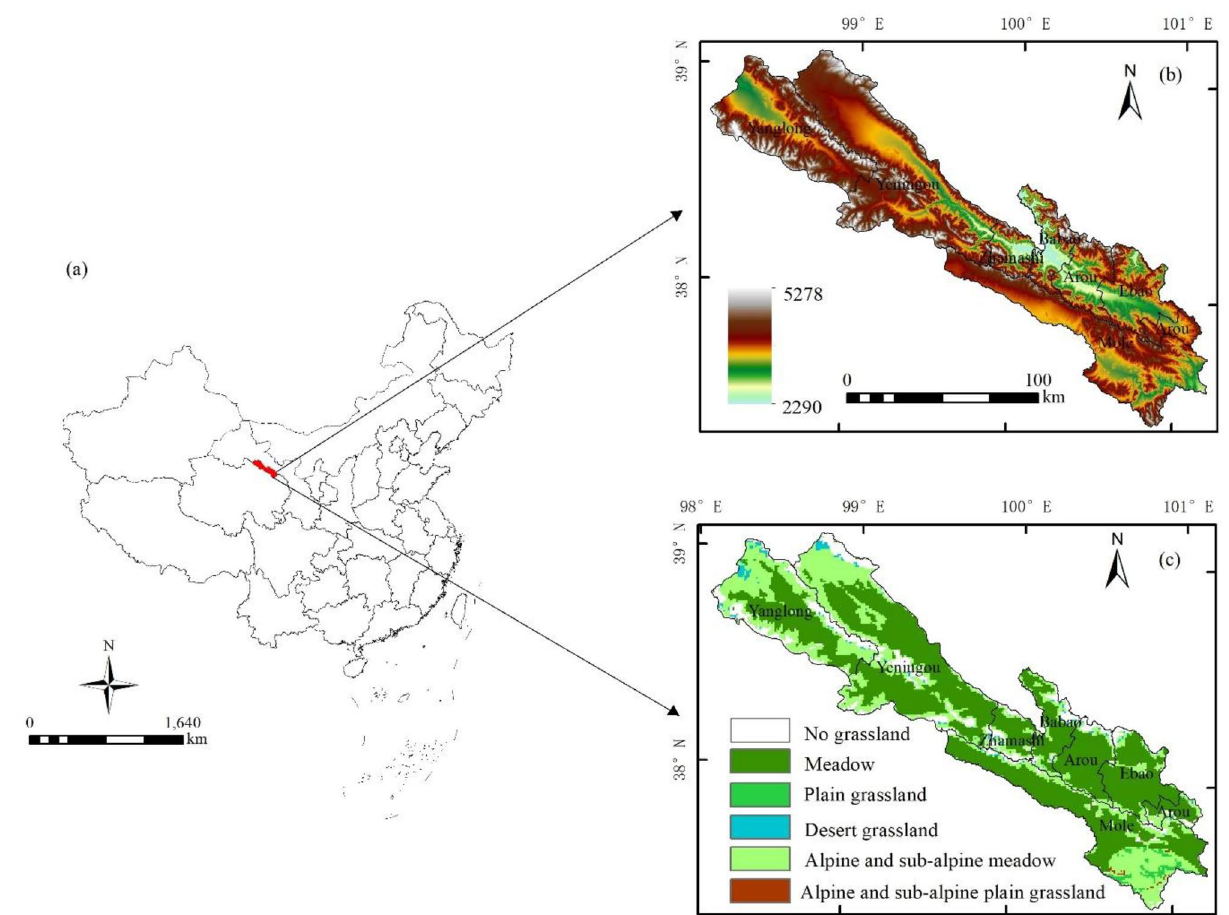
Figure 1. Geographical location ( a ), altitude ( b ), and the distribution of grassland types ( c ) in Qilian County. The map was generated by ArcGIS 10.2, URL: https:// www. esri.